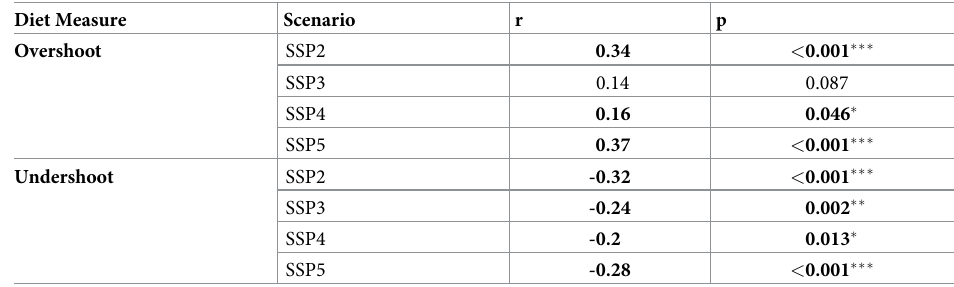
Table 3. Correlation between the change in the level of agricultural imports per capita and change in the dietary overshoot and dietary undershoot metrics between 2010–2050 for SSPs 2–5. Statistically significant relationships are shown in bold.